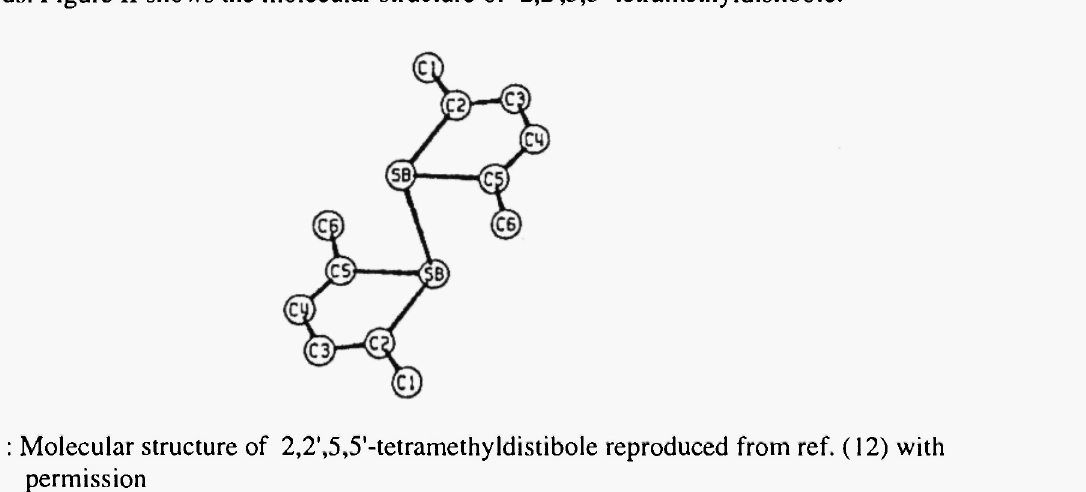
Figure II : Molecular structure of 2,2',5,5'-tetramethyldistibole reproduced from ref. (12) with